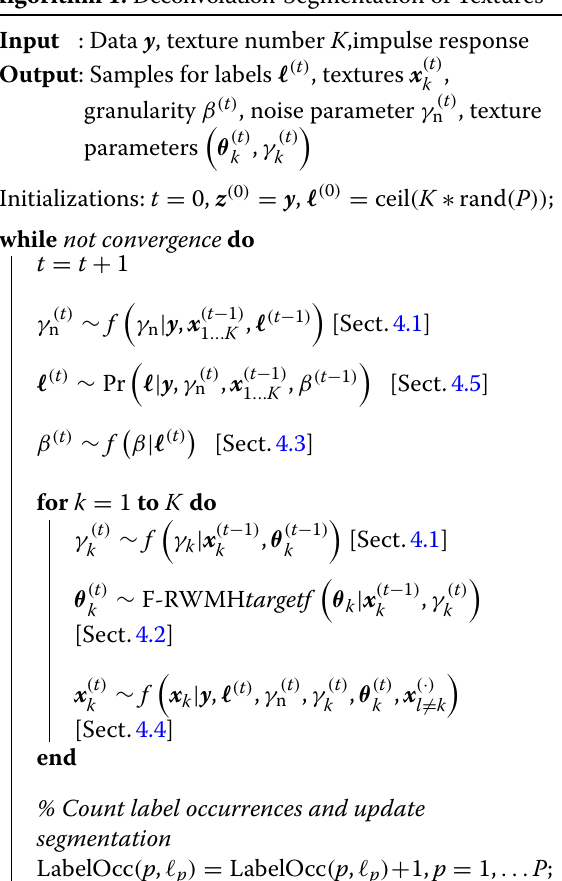
Algorithm 1. Under different scenarios, the algorithm has been run several times from identical and different